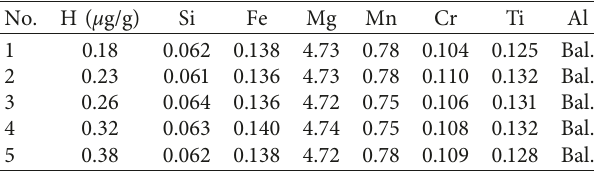
Figure 1: Schematic diagram and macroscopic view of the hydrogen testing sample. Table 1: Chemical compositions of wires